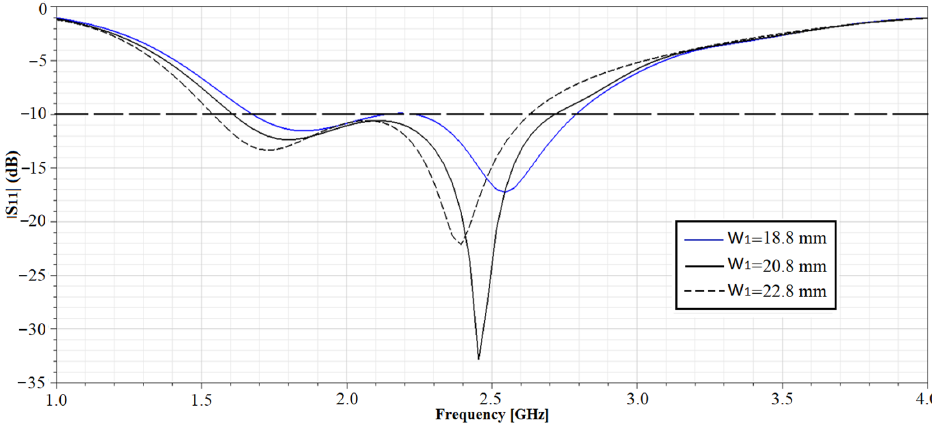
Figure 3. Variation of resonant frequency and reflection coefficient |S 11 | with respect to width W 1 .